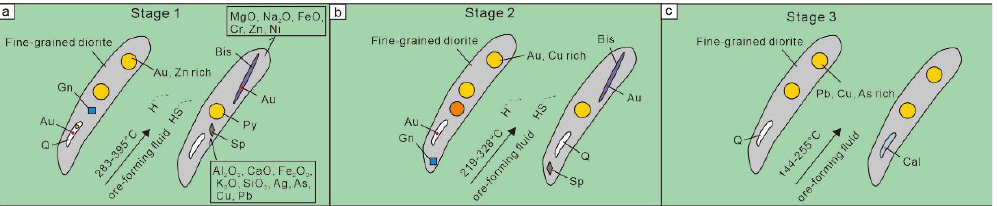
Figure 10. Schematic diagram of stage 1 to 3 gold deposition mechanism of the Wulong gold deposit. ( a ). Schematic diagram of stage 1 gold deposition mechanism; ( b ). Schematic diagram of stage 2 gold deposition mechanism; ( c ). Schematic diagram of stage 3 gold deposition mechanism.